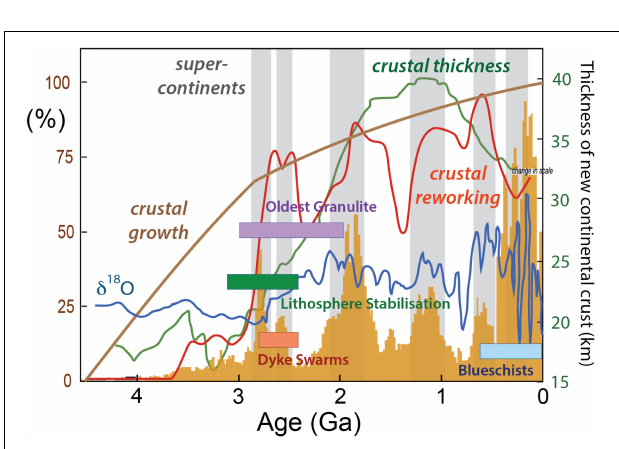
FIGURE 13 | A summary of some of the changes that appear to mark the end of the Archean. These include the development of supercontinents/supercratons, marked by vertical gray bars (Hoffman, 1996; Zhao et al., 2002; Bleeker, 2003; Cawood et al., 2013; Evans, 2013), stabilization of lithosphere and the oldest major dyke swarms (Cawood et al., 2018), the increase in the degree of crustal reworking as indicated by Hf isotope ratios in zircon (Belousova et al., 2010; Dhuime et al., 2012), the development of significant peaks in the age distribution of zircons (Campbell and Allen, 2008; Voice et al., 2011), a shift in the composition of juvenile crust from mafic to more intermediate compositions accompanied by an inferred increase in crustal thickness (Dhuime et al., 2015), and the step-up in the δ 18 O values in zircons (Valley et al., 2005; Spencer et al.,